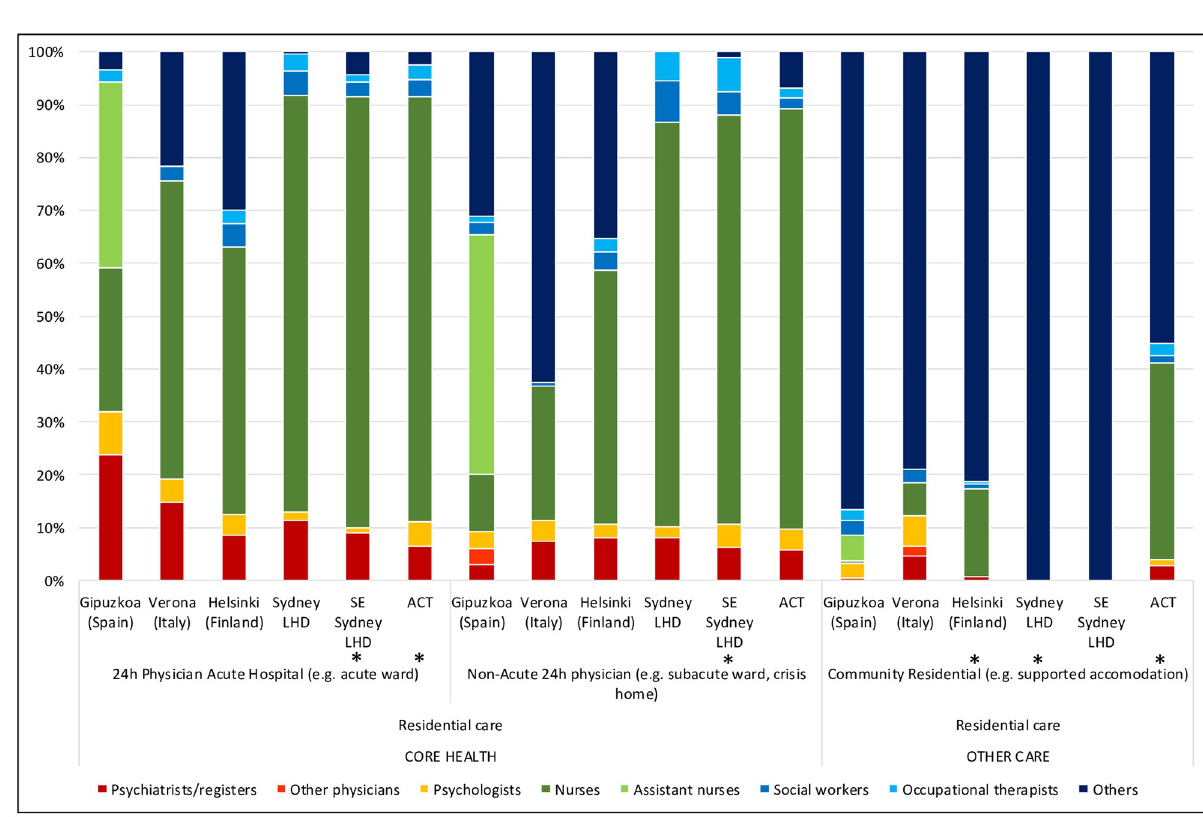
Fig 4. Percentage distribution of workforce in adult mental health services for residential care in the six study areas. � Missing data.